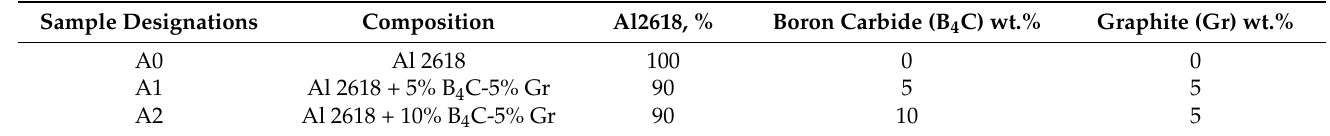
Table 2. Percentage of particulate reinforcement by weight.